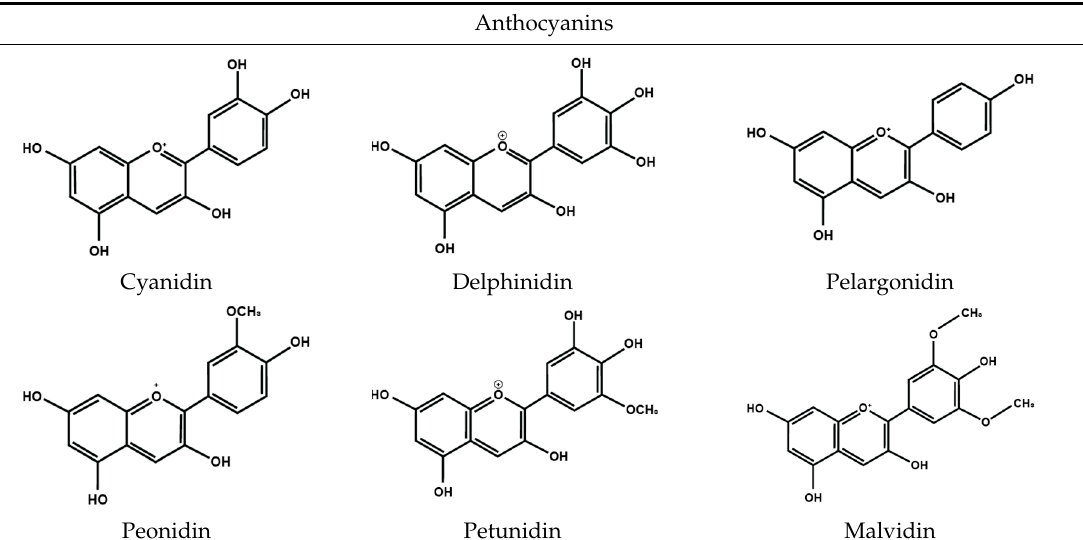
Table 1. Chemical structures of different sub-groups of flavonoids.